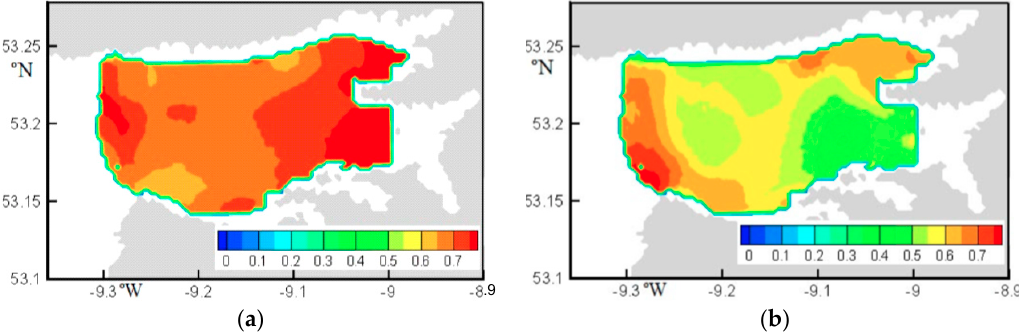
Figure 3. Willmott’s model skill score for the month of December 2011: ( a ) zonal; and ( b ) meridional surface velocity component (from O’Donncha et al. [19]).